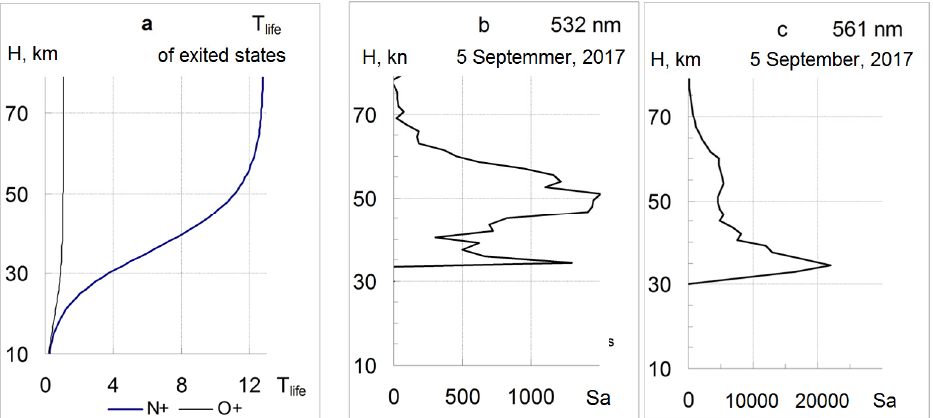
Figure 11. Vertical profiles of the lifetimes of the lower-level states N + and O + ions (see Table 2) ( a ); obtained on 5 September 2017 in the middle atmosphere signal Sa determined as: Sa = “the total backscattering signal” minus “the molecular scattering signal” minus “the background noise signal”, 532 nm (N + ) ( b ); 651 nm (O + ) ( c ).